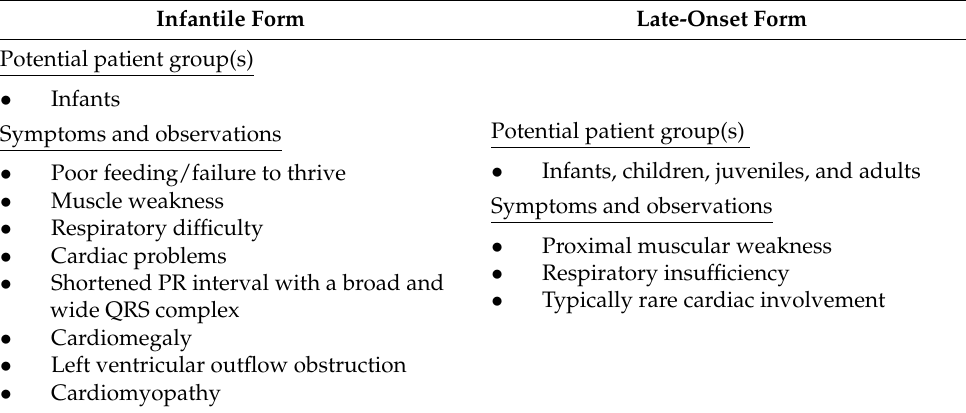
Table 2. Symptoms and observations suggestive of potential PD